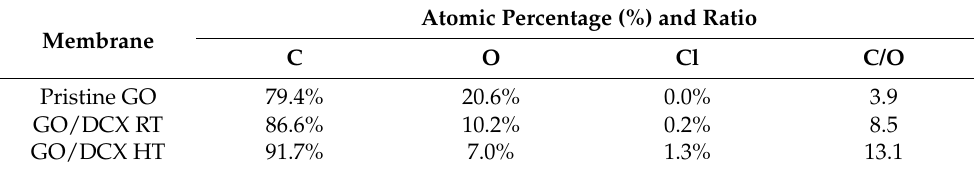
Table 1. Atomic percentage of each GO membrane obtained by EDS.